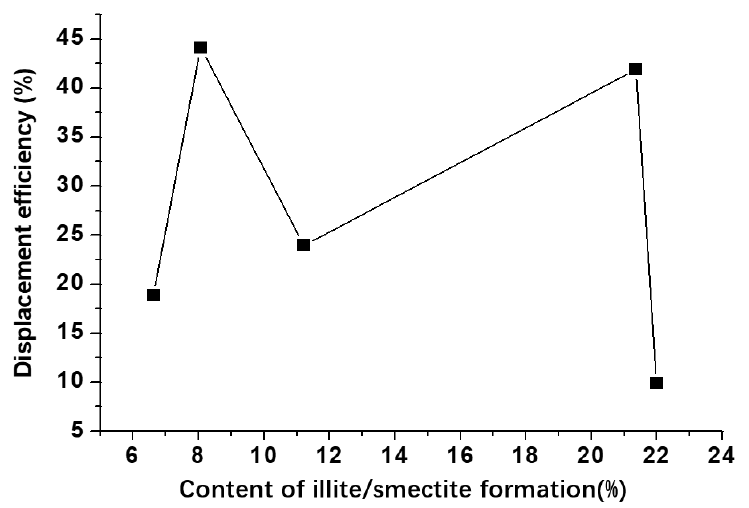
Figure 15. The efficiency of oil displacement under 1 atm versus the content of illite/smectite.